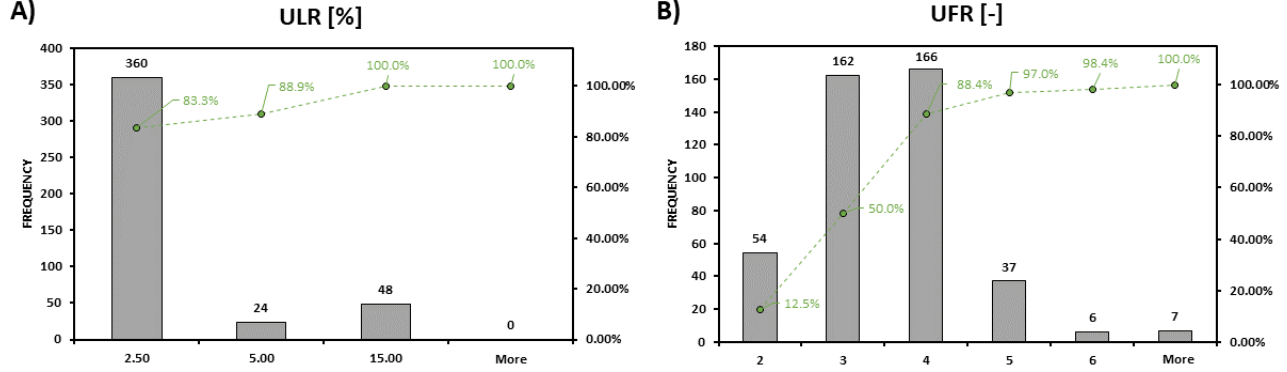
Figure 6. The histograms presenting the distribution of obtained results for: ( A )—Upward Light Ratio and ( B )—Upward Flux